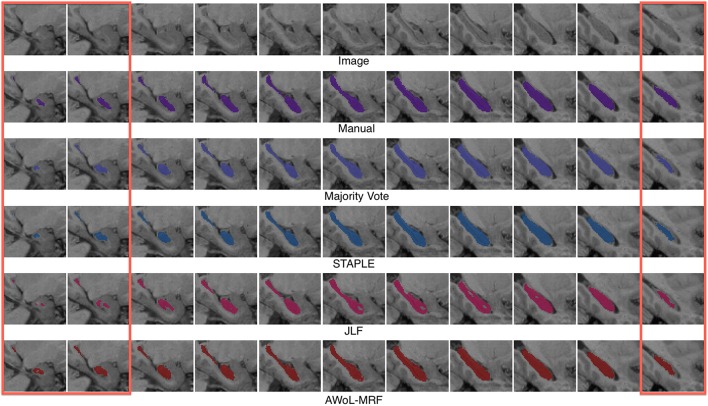
Experiment II Qualitative Analysis: Comparison of manual vs. automatic segmentation methods. The red rectangle illustrates a section where the superiority of the AWoL-MRF approach is particularly apparent. The segmentations are performed using 3 atlases, and the Dice scores are as follows: majority vote: 0.875, STAPLE: 0.878, JLF: 0.856 AWoL-MRF: 0.891. The segmentation of the right hippocampus is shown in sagittal view.